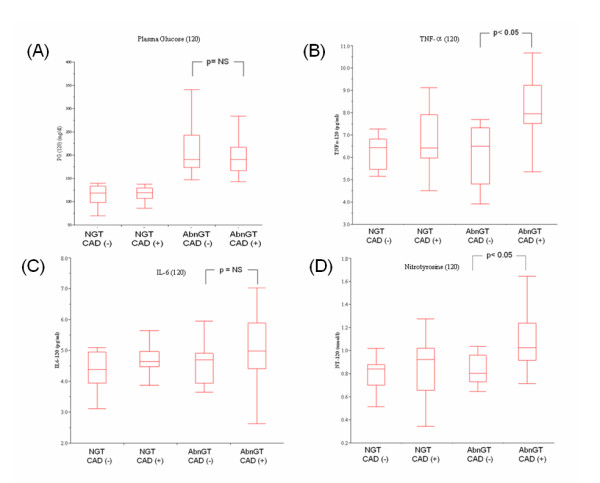
Box and whisker plots of PG, TNF-α, IL-6 and nitrotyrosine levels at 2-hr after 75 g-OGTT. Each plot indicates the median (middle bar in rectangle), 10th (bottom of bar), 25th (bottom of rectangle), 75th (top of rectangle), and 90th centiles (top of bar) in patients categorized by the presence of CAD and GT status. Patients with CAD and AbnGT have significantly higher postchallenge TNF-α and nitrotyrosine levels at 2-hr compared to those without CAD, whereas IL-6 and glucose concentrations are not significantly different either in patients with NGT or AbnGT. *p < 0.05 by Kruskal-Wallis test followed by Mann- Whitney U test with Bonferroni correction.